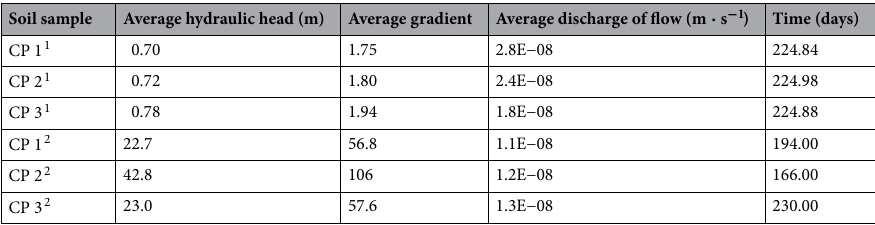
Table 4. Main hydraulic characteristics of the performed column tests. 1,2 Samples from first and second sampling